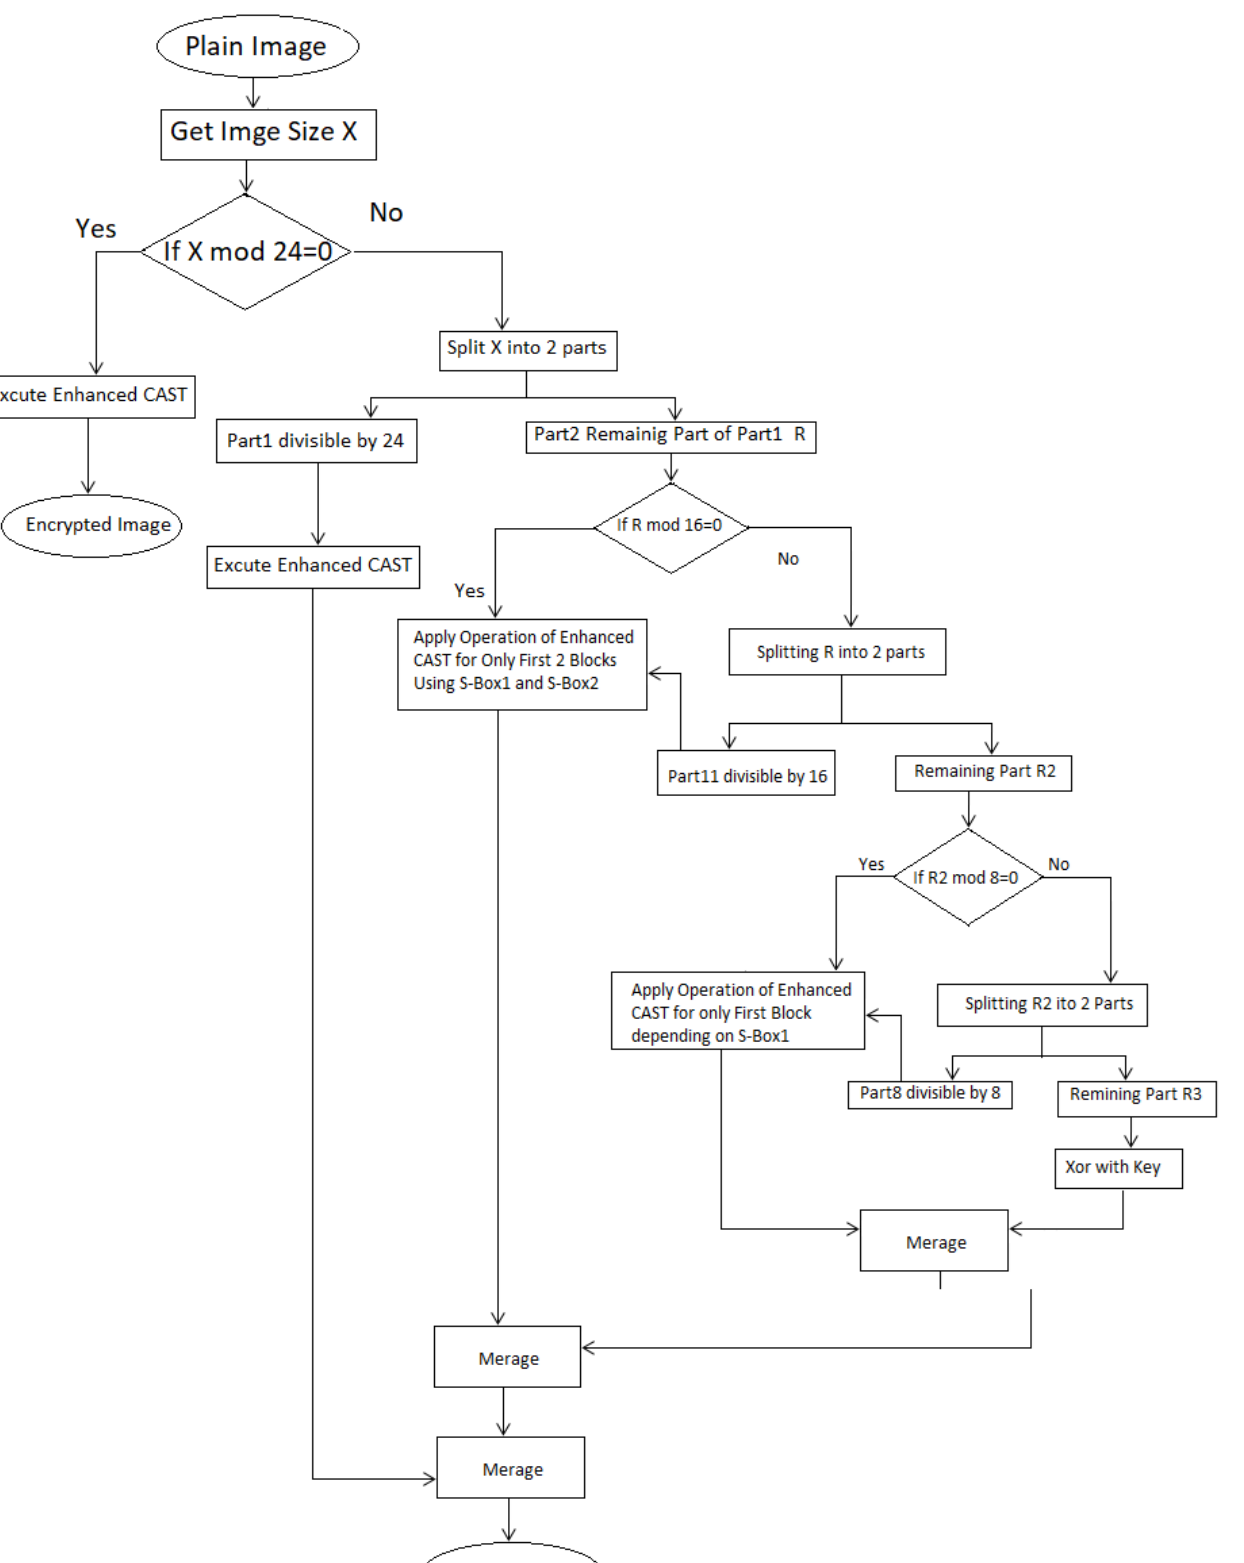
Figure 2. Flowchart of the proposed encryption